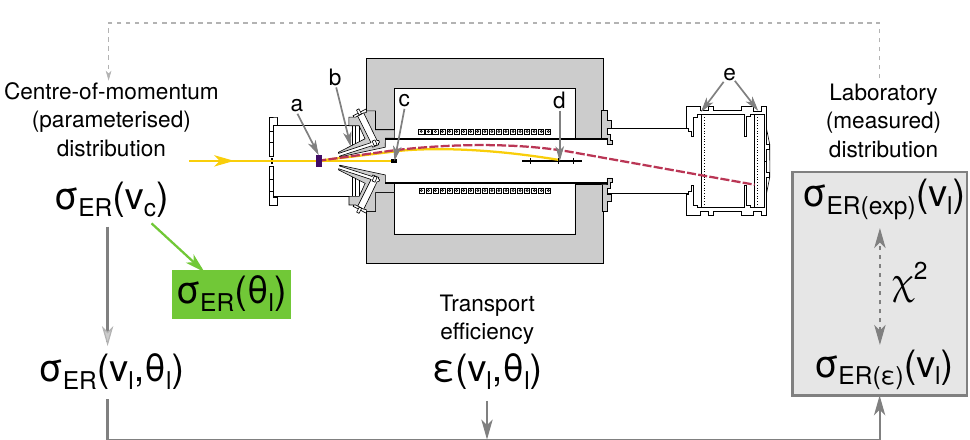
Figure 1. Flowchart of the method for extracting precise angular distributions from measurements made with the SOLITAIRE device, with a schematic of the device and labels of its key features included for context. The labelled components are (a) the target, (b) the iron cone forming part of the solenoid’s magnetic shielding (all of which is indicated by the shaded grey areas), (c) the Faraday cup, used to catch the direct beam, (d) the axial blocking rod and discs and (e) the two multi-wire proportional counters (MWPCs). Example radial trajectories are also included for an elastically scattered beam particle (orange line) and an evaporation residue (dashed pink line). The flowchart shows the routine described in Section 3, including the initialisation step for estimating initial parameters of the σ ER ( v c ) distribution, and the final transformation to the angular distribution σ ER ( θ l ).